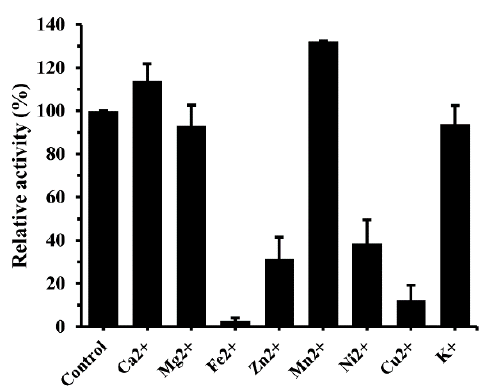
Figure 5. Effect of metal ions on recombinant GSJ. The activity was assayed after the incubation of the